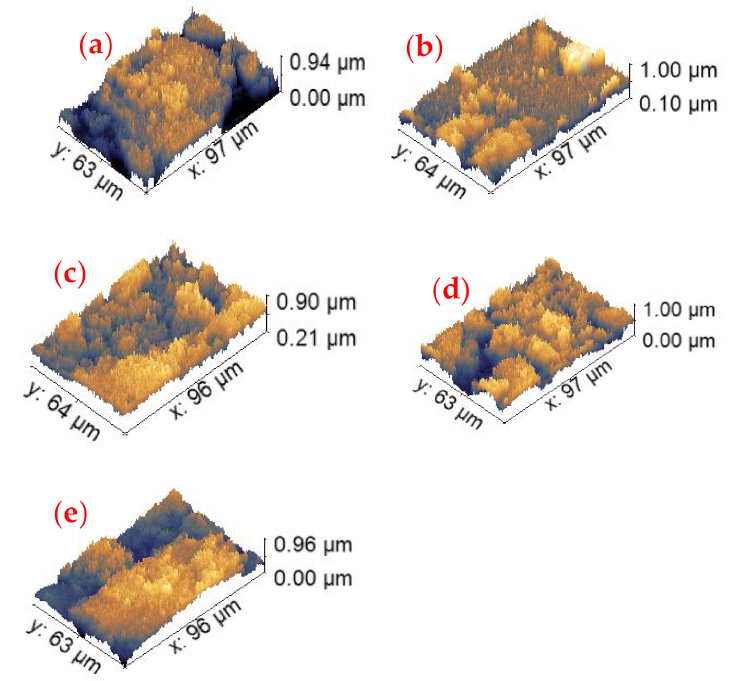
Figure 4. ( a – e ) Behavior of surface roughness of HAP doped with Ag/V in powder phase: ( a ) 0.0